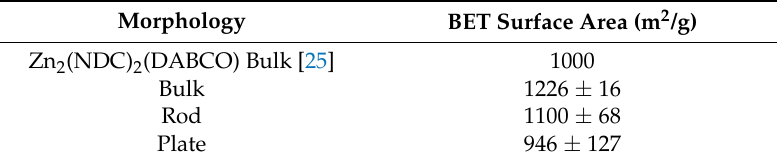
Table 2. BET surface areas and standard error calculated from nitrogen isotherms at 77 K for three (3) samples of the bulk morphology and four (4) samples of the plate-like and rod-like morphologies of [Zn 2 (NDC) 2 (DABCO)] n and a reference value .